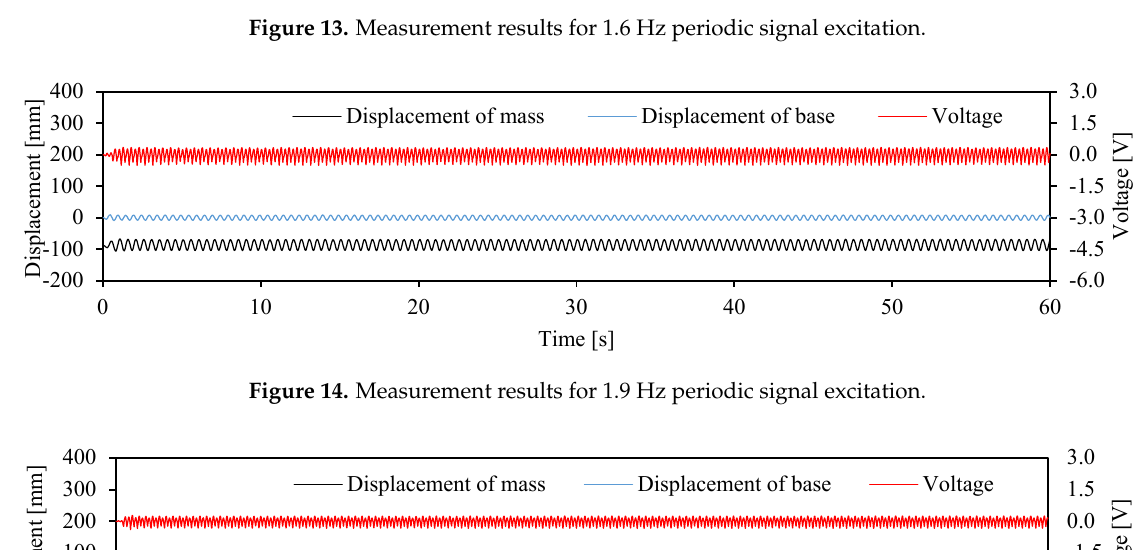
were 7.34 and 5.33 mm, respectively, which resulted in 0.80 mW of power generated.